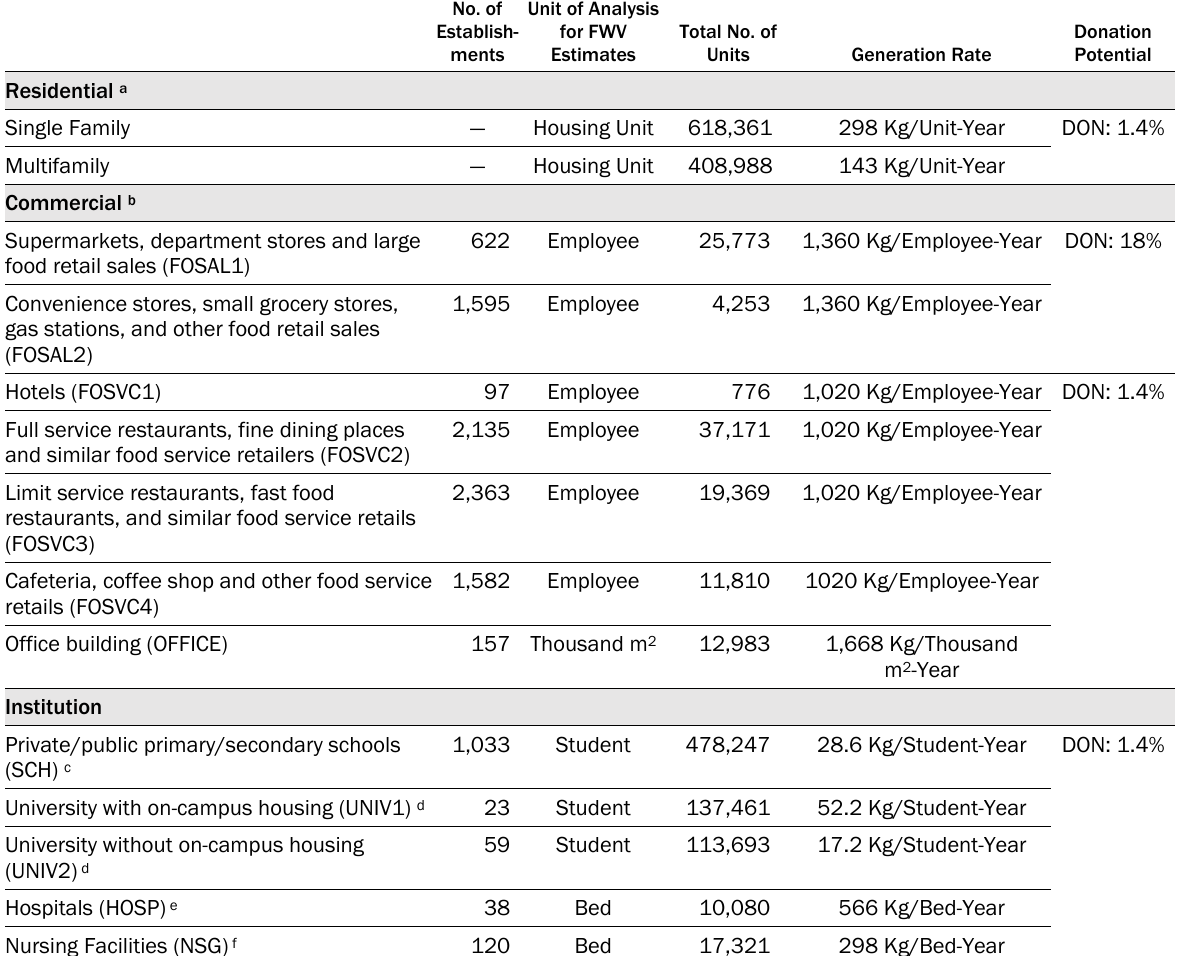
Table 2. Chicago FW Generator Summary and Modeling Parameters